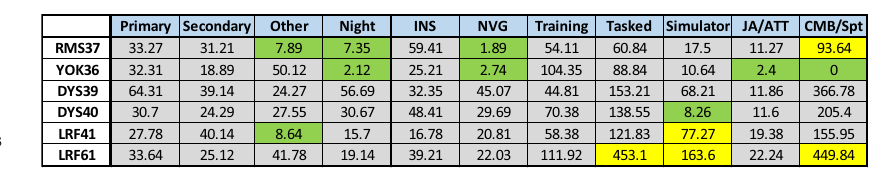
Table 4. Consolidated Levene ’ s test